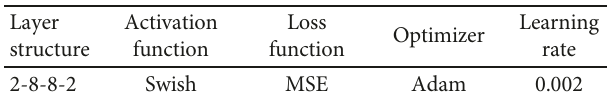
Table 1: Hyperparameter con fi guration of the basic model: VDP